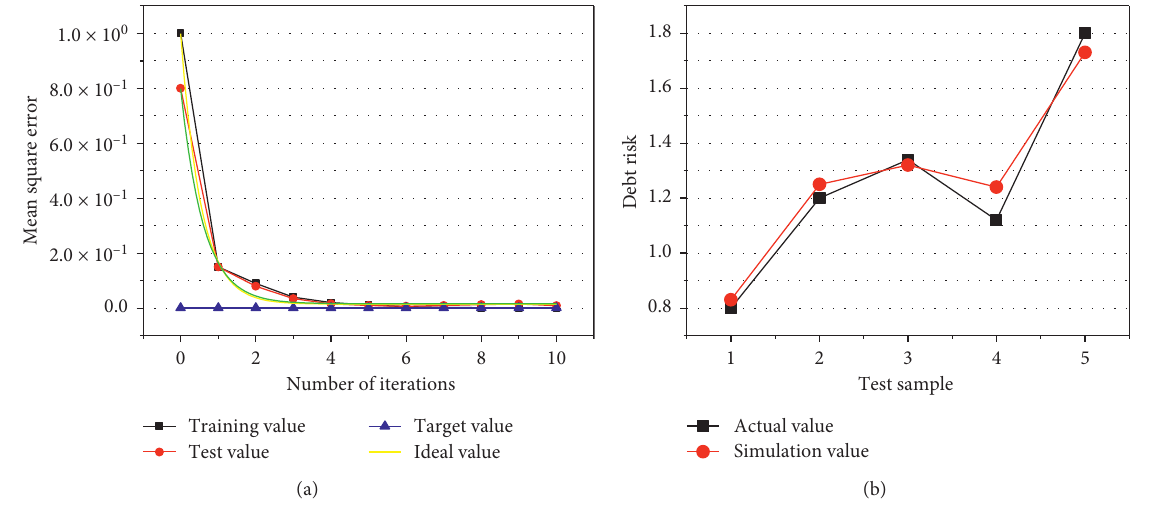
Figure 8: Change of simulation value, real value, and error of test